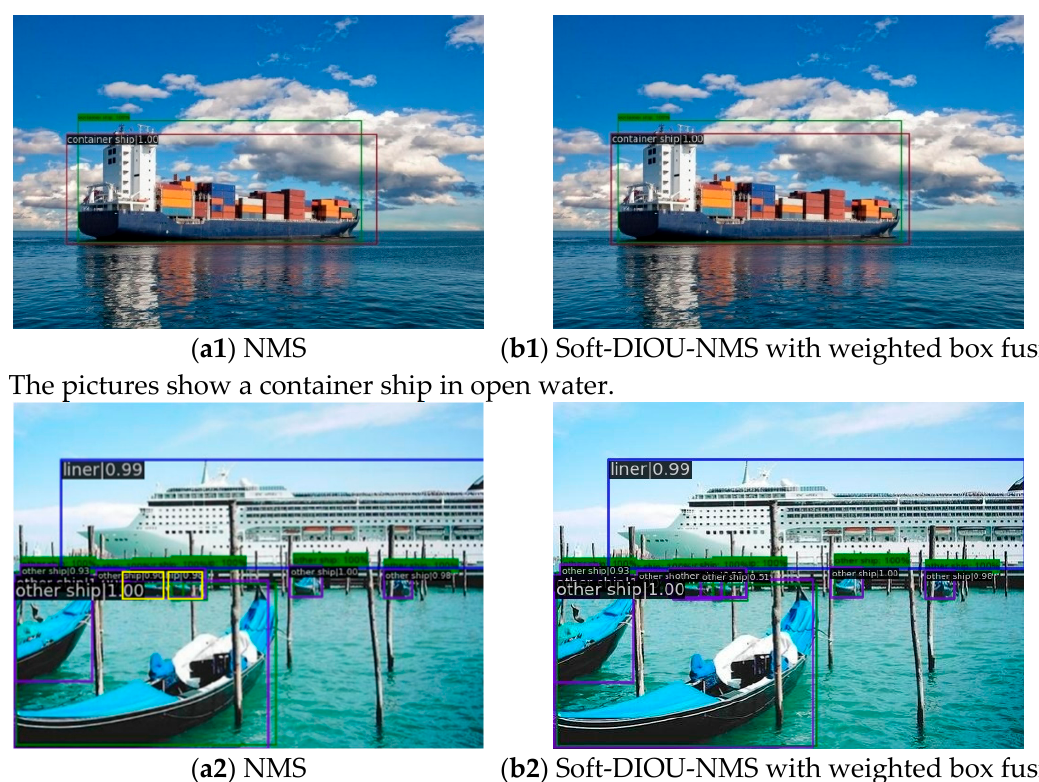
Figure 10. Comparison of detection results of NMS and weighted box fusion for Soft-DIOU-NMS (Green box is real target box and yellow box is missed ship target).